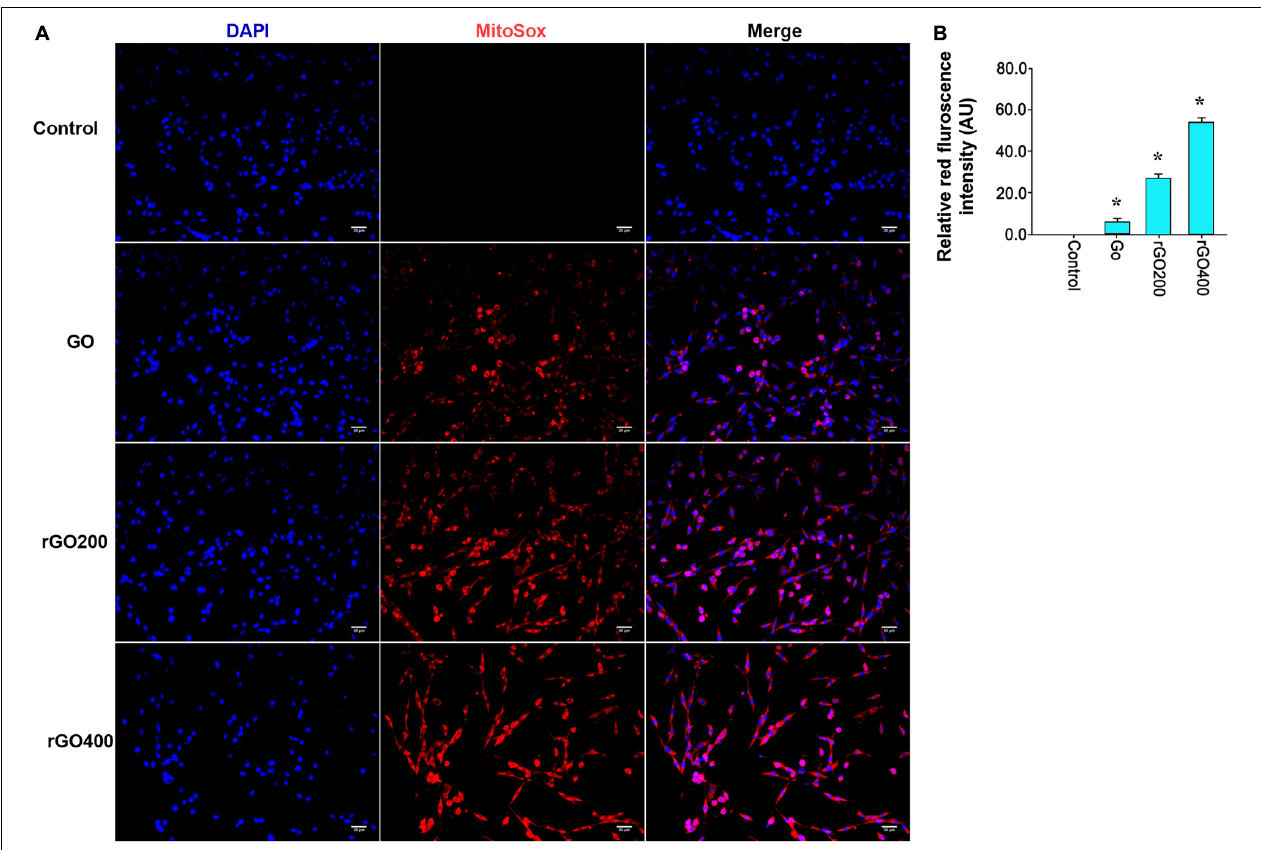
FIGURE 4 | ROS was mainly generated through mitochondria. (A) Representative MitoSox staining of GO and rGO treated H9C2 cells. DAPI was used to stain nucleus. (B) The relative MitoSox intensity of the control and treated cells ( n = 3). * p <